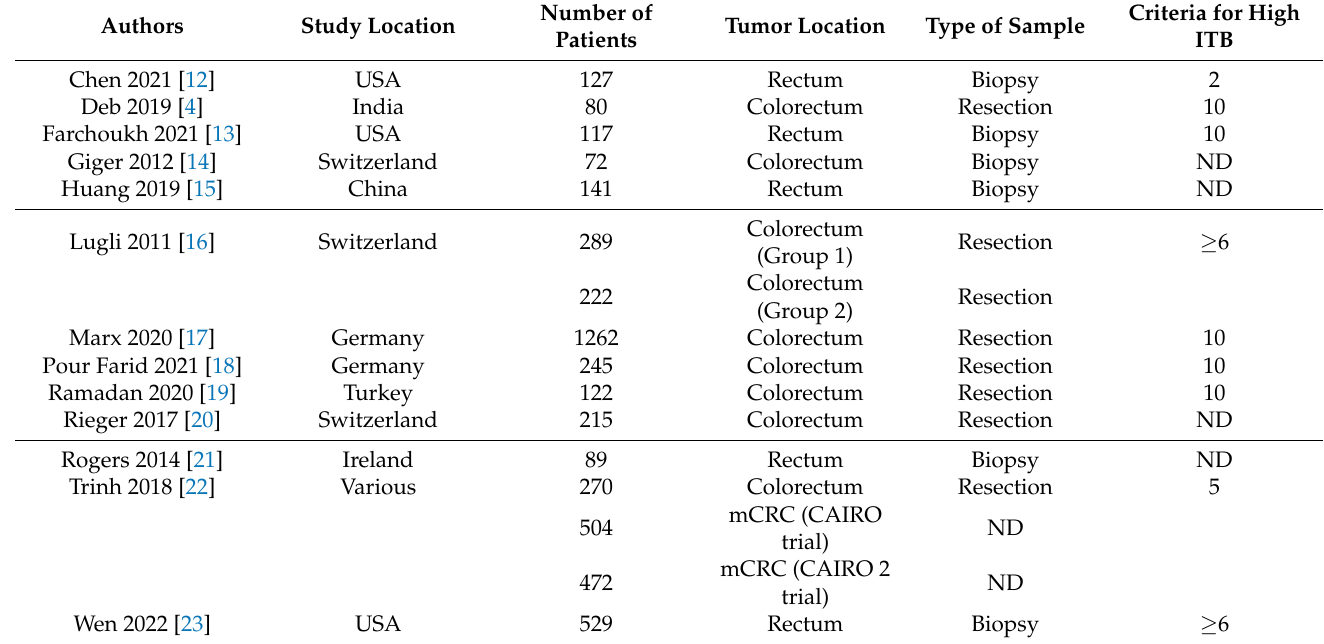
Table 1. Main characteristics of the eligible studies.